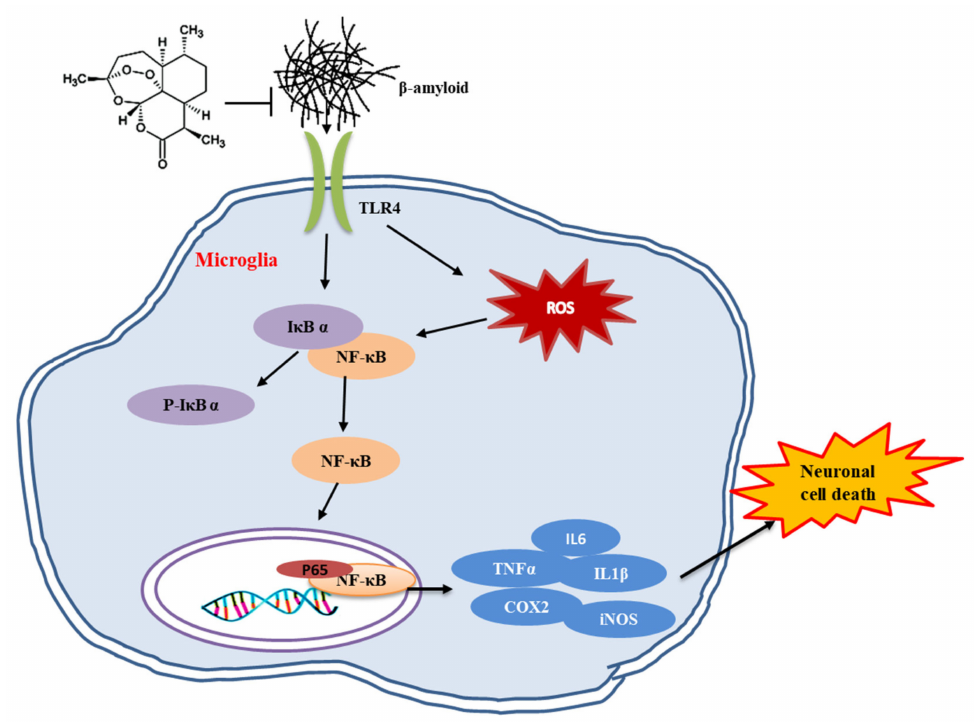
Figure 10. The possible mechanism of Artemisinin against neuroinflammation in AD. A β 1–42 stim- ulated microglial receptor TLR4 to activate the I κ B α /NF- κ B signaling pathway, resulting in the massive expression of intracellular inflammatory factors (IL-6, TNF- α , IL-1 β ) and an increase in the level of ROS(COX2, iNOS). While Artemisinin pretreatment suppressed the activation of the TLR4/I κ B α /NF- κ B pathway and reduced the release of inflammatory factors, which in turn protects nerve cells from damage by improving the inflammatory environment in the brain.